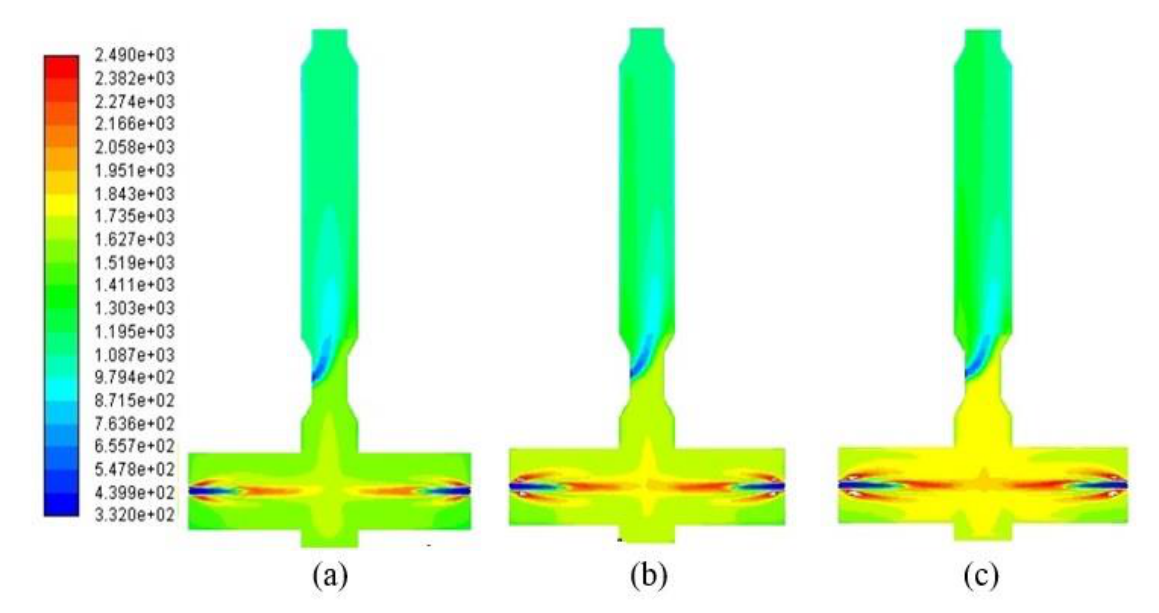
Figure 7. Comparison of temperature (Kelvin) distribution along the central plane for ( a ) 50% O 2 , ( b ) 75% O 2 , and ( c ) 95% O 2 .